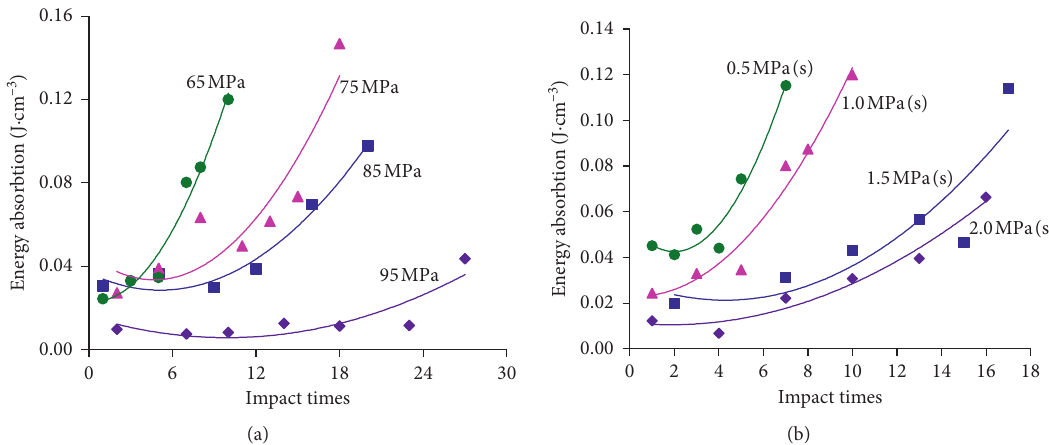
Figure 14: Change law of energy consumption per volume of rock with the increase of disturbance impact times: (a) unloading rate is 1.0MPa/s (the numbers in figure represents the preloaded axial static stress of specimen); (b) the preloaded axial pressure is 95MPa (the number in the figure represents the unloading rate).